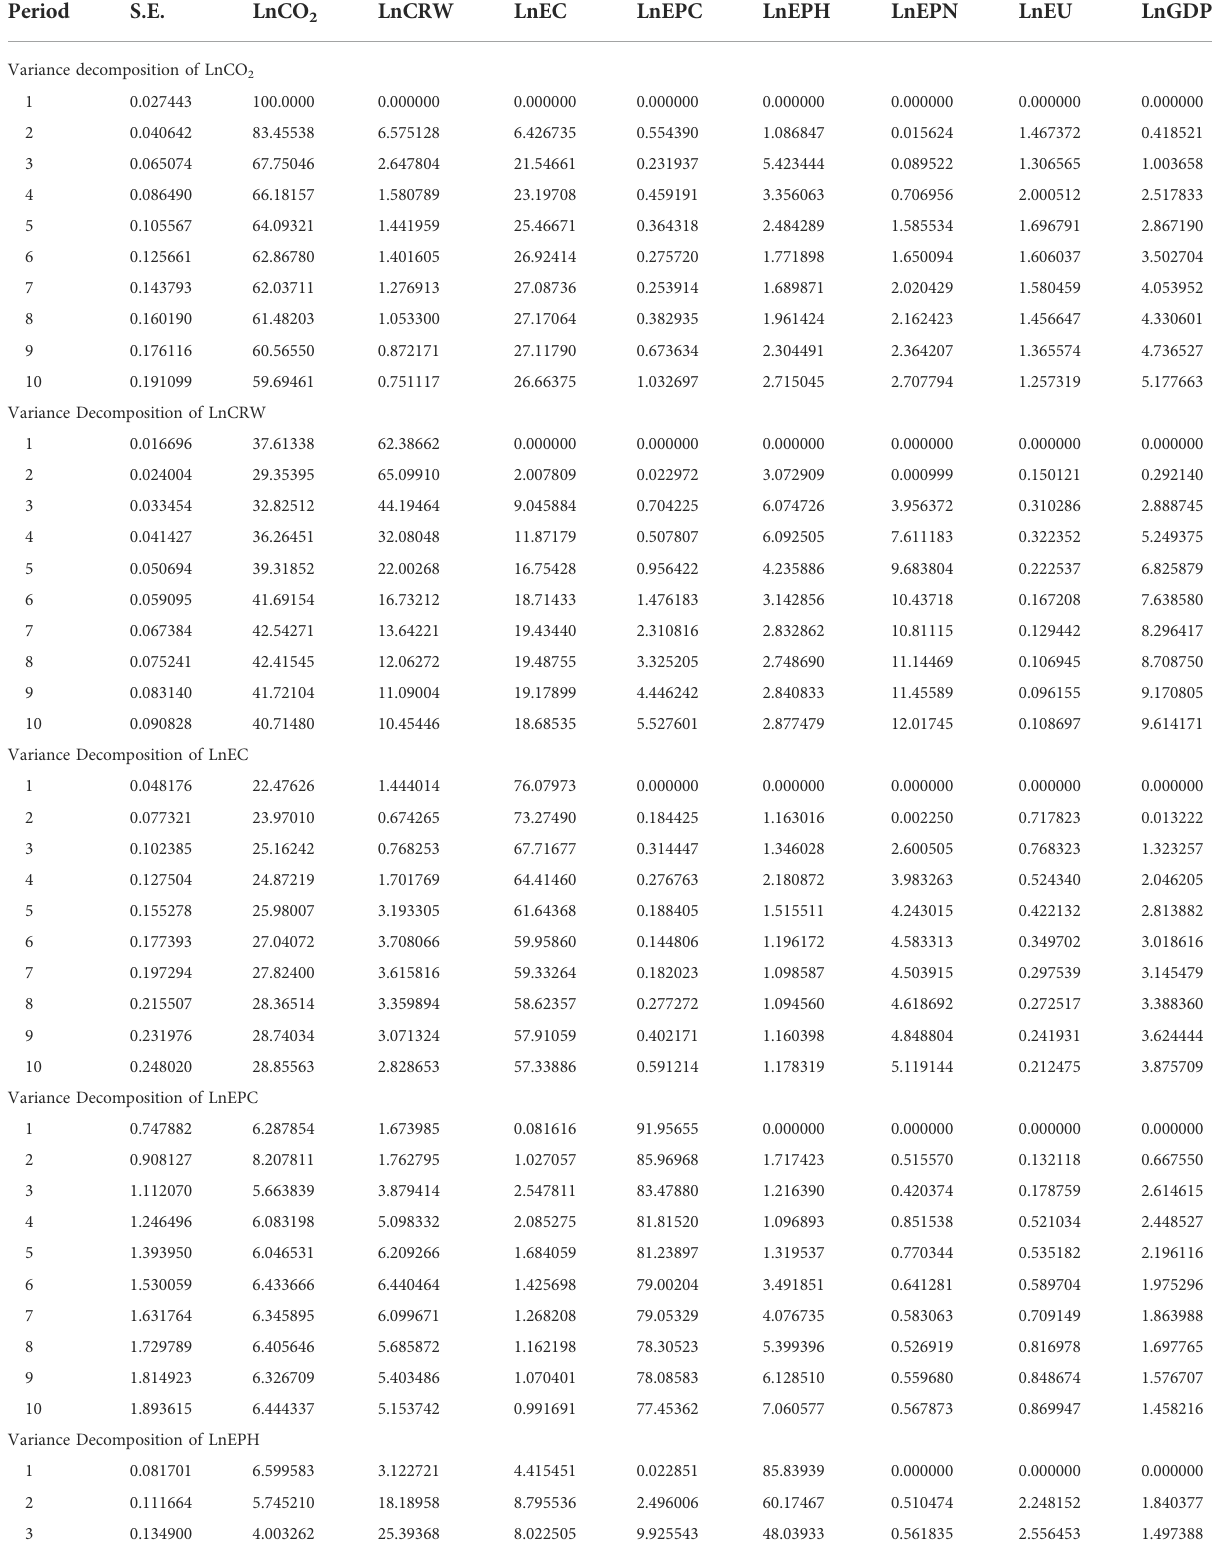
TABLE 13 Variance decomposition using cholesky ordering: LnCO 2 , LnCRW, LnEC, LnEPC, LnEPH, LnEPN, LnEU and